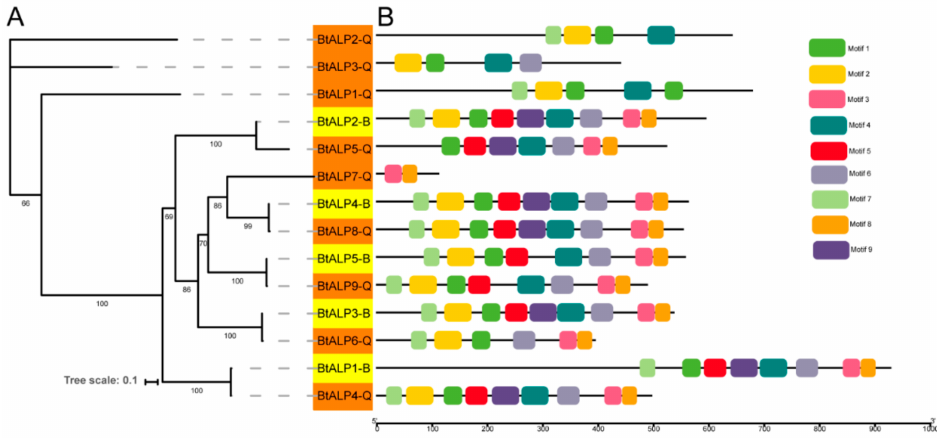
Figure 2. Phylogenetic relationships and protein motif analysis of B. tabaci MEAM1 and MED. ( A )— the maximum-likelihood phylogenetic tree generated by IQ-tree and the bootstrap test was performed with 1000 replicates. Yellow shading marks ALPs in B. tabaci MEAM1. Orange shading marks ALPs in B. tabaci MED. ( B )—all motifs were identified by the MEME database with the complete amino acid sequences of ALPs, and are presented in Supplementary Figure S1.